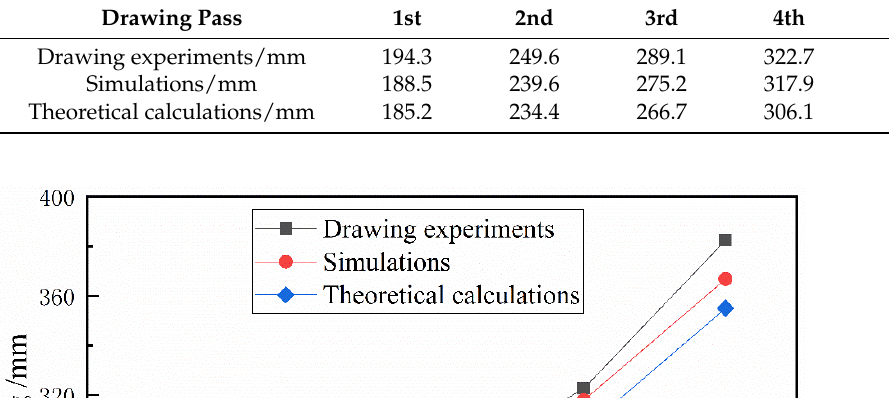
Table 4. Comparison of composite length from drawing experiments, simulations, and theoretical calculations.